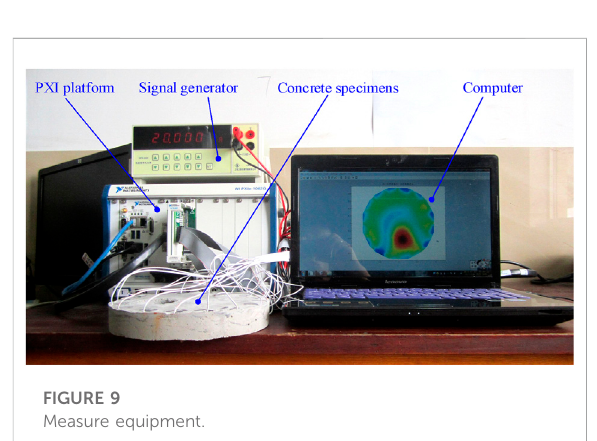
FIGURE 9 Measure